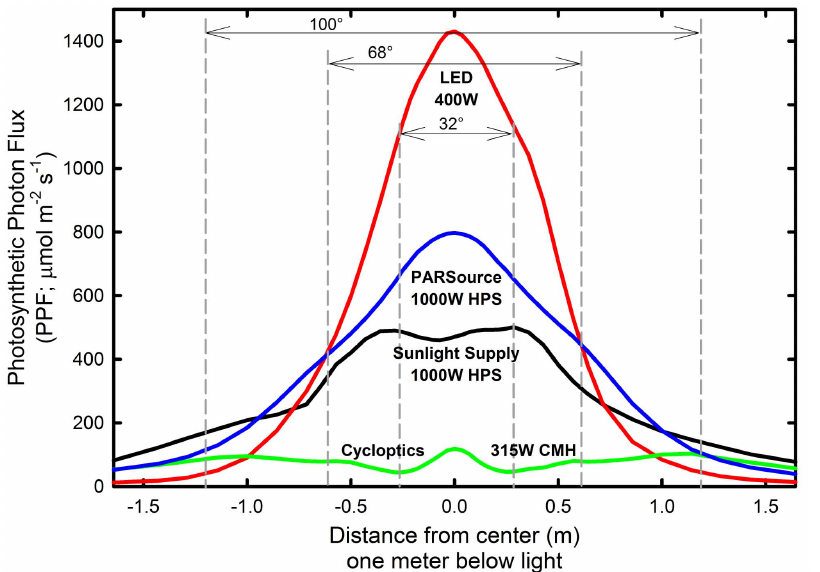
Figure 1. The photon distribution of four fixtures with similar photon efficiency. Each line represents a cross section of the photon intensity below the fixture. The LED fixture (Lighting Sciences Group) uses optics to achieve a narrow distribution, with the majority of the photons falling in a concentrated pattern directly below the fixture. Conversely, the Cycloptics ceramic metal halide fixture is designed for even light distribution, and therefore casts uniform radiation over a large surface area. Since the area increases exponentially as the distance from the center increases, an equal photon flux farther from the center represents a larger quantity of total photons.